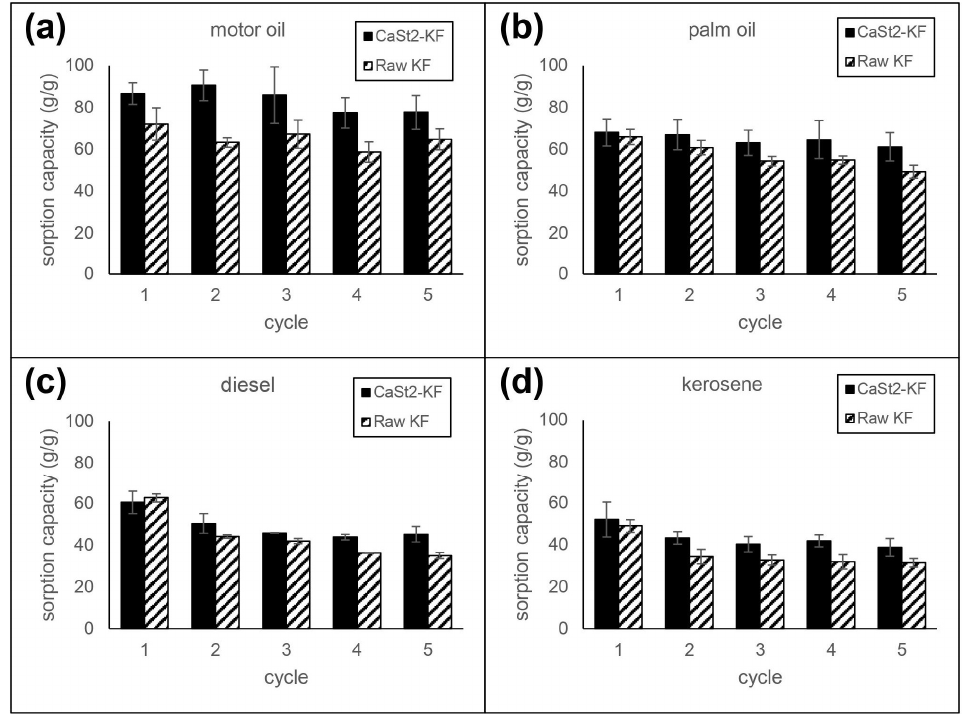
Figure 7. Reusability of CaSt 2 -KF and raw-KF in ( a ) motor oil, ( b ) palm oil, ( c ) diesel, and ( d ) kerosene.